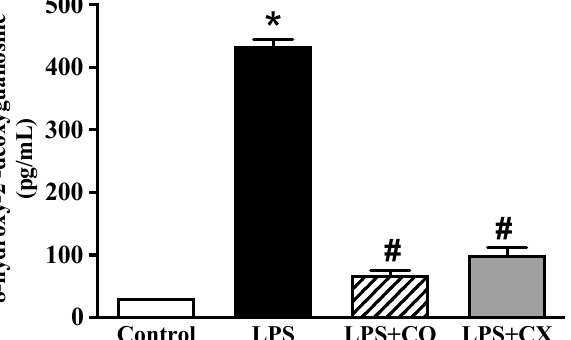
Figure 5. Effects of CO on DNA damage. Cells were treated with 2% CO or 10 µ M CX with or without LPS. After 24 h, concentration of 8-OHdG was evaluated using an ELISA kit. Values displayed are mean ± S.E.M ( n = 5), * p < 0.05 vs. control and # p < 0.05 vs. LPS.